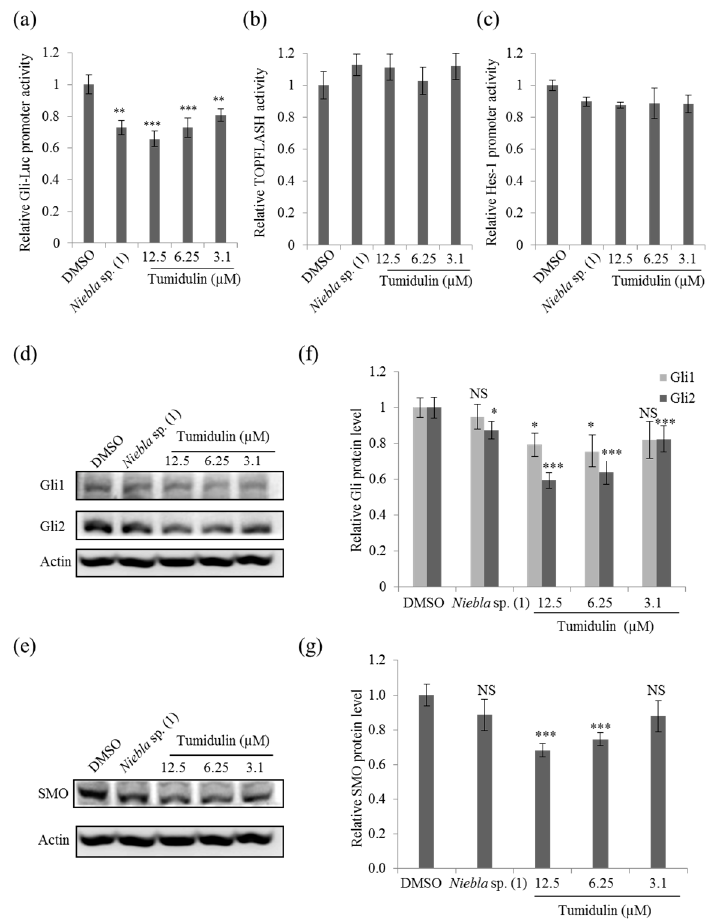
Figure 5. Effects of crude acetone extracts of Niebla sp. (1) and tumidulin on transcription factor activity and the expression of proteins related to cancer stemness. ( a – c ) Relative activities of promoters related to Hedgehog, Wnt, and Notch signaling pathways. HEK293T cells were co-transfected with the pRL-TK (Renilla) plasmid and the pGli-luc ( a ), pTOPFLASH ( b ), and pHES-luc ( c ) reporter plasmids (firefly). After 12 h, transfected cells were treated with crude extracts of Niebla sp. (1) or various concentrations of tumidulin and incubated for an additional 48 h. The relative firefly luciferase activity of treated vs. control groups is shown. Quantitative data were obtained from at least two independent experiments. ( d – g ) CSC221 cells were treated with 5 µ g/mL Niebla sp. (1) or various concentrations of tumidulin. After incubation for 48 h, cells were lysed and total protein was subjected to immunoblot analyses with the indicated antibodies. ( d , e ) Representative immunoblots of Gli1/2 ( d ) and SMO ( e ). ( f , g ) Relative protein levels of Gli1/2 ( f ) and SMO ( g ) compared with the untreated group. Data represent the mean ± SEM, and analysis was performed by one-way ANOVA. * p < 0.05; ** p < 0.01; *** p < 0.001; NS: no significant difference compared with DMSO-treated CSC221 cells.